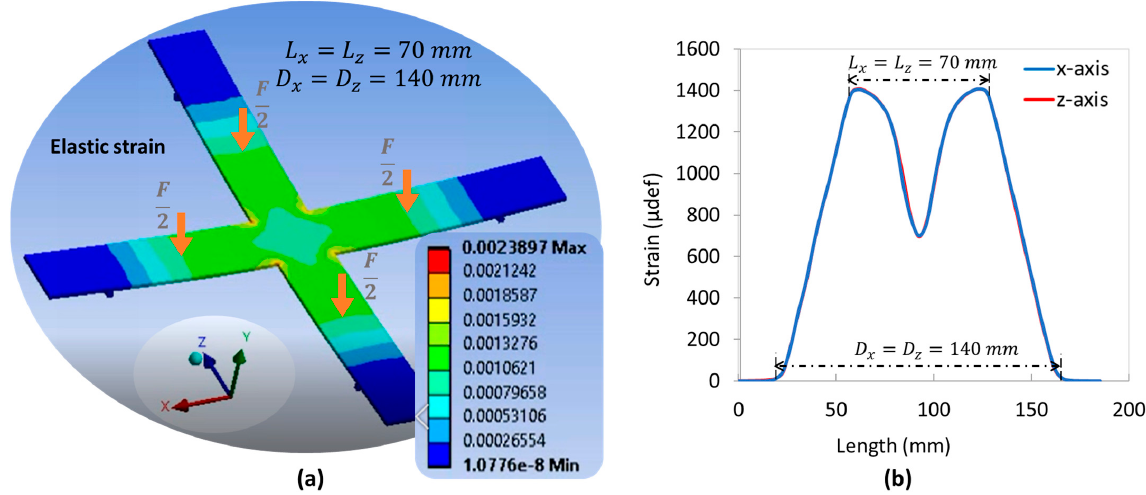
Figure 7. Symmetric bidirectional symmetrical model using FEM: ( a ) four-point flexure design with load applied on x- and z -axis ( L x = L z and D x = D z ); ( b ) strain in both x -axis and z -axis versus their own length.